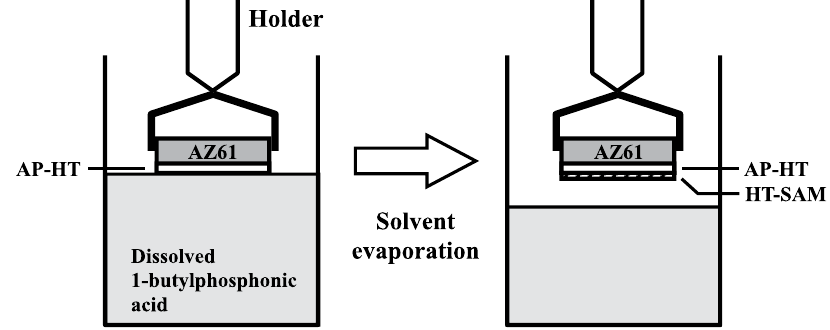
Figure 9. Schematic apparatus of the T-BAG method for the self-assembled monolayer (SAM) surface treatment of AP-HT specimens.